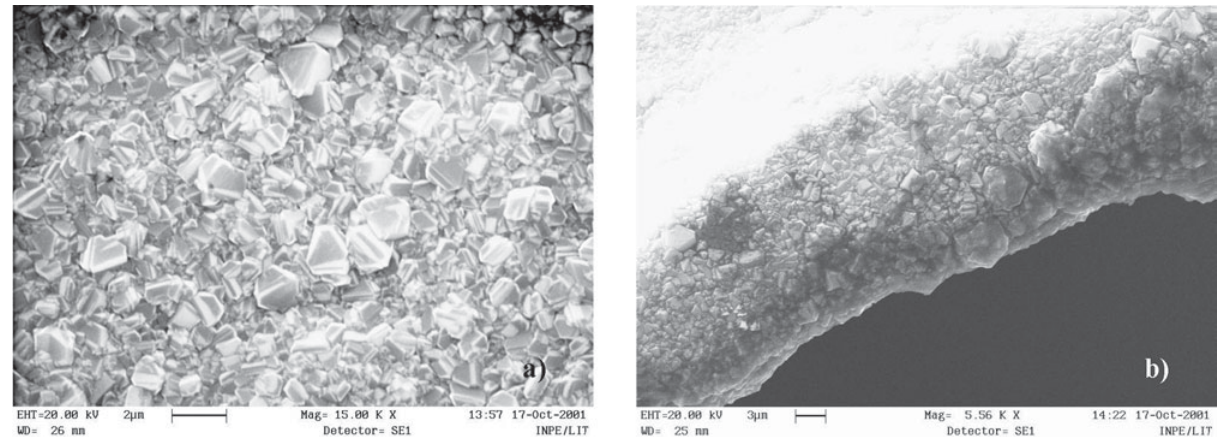
Figure 1. Scanning electron micrographs of boron-doped diamond film (a) superficial vision; (b) vision of the border of the